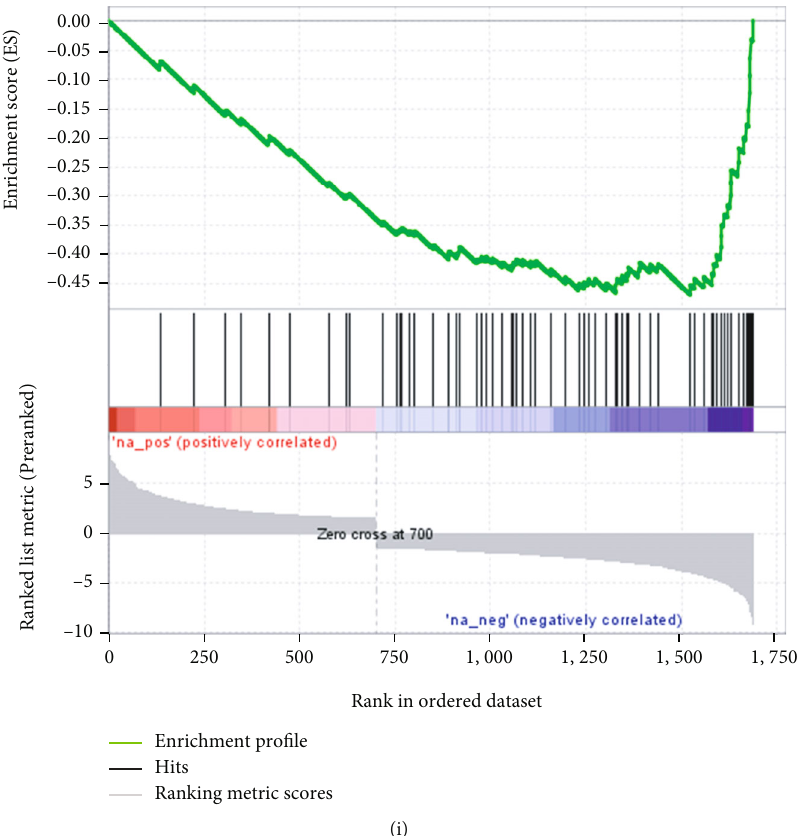
Figure 3: Identi fi cation of DEGs and their biological functions for Ewing ’ s sarcoma. (a) Heatmap showing 1688 DEGs between Ewing ’ s sarcoma and mesenchymal stem cells. Red represents upregulated genes and green represents downregulated genes. GO including (b) cell component, (c) molecular function, and (d) biological process and (e) KEGG enrichment results depicting underlying biological functions for these DEGs. (f – i) GSEA results according to these DEGs, including extracellular matrix, collagen-containing extracellular matrix, DNA binding transcription factor activity, and cell substrate